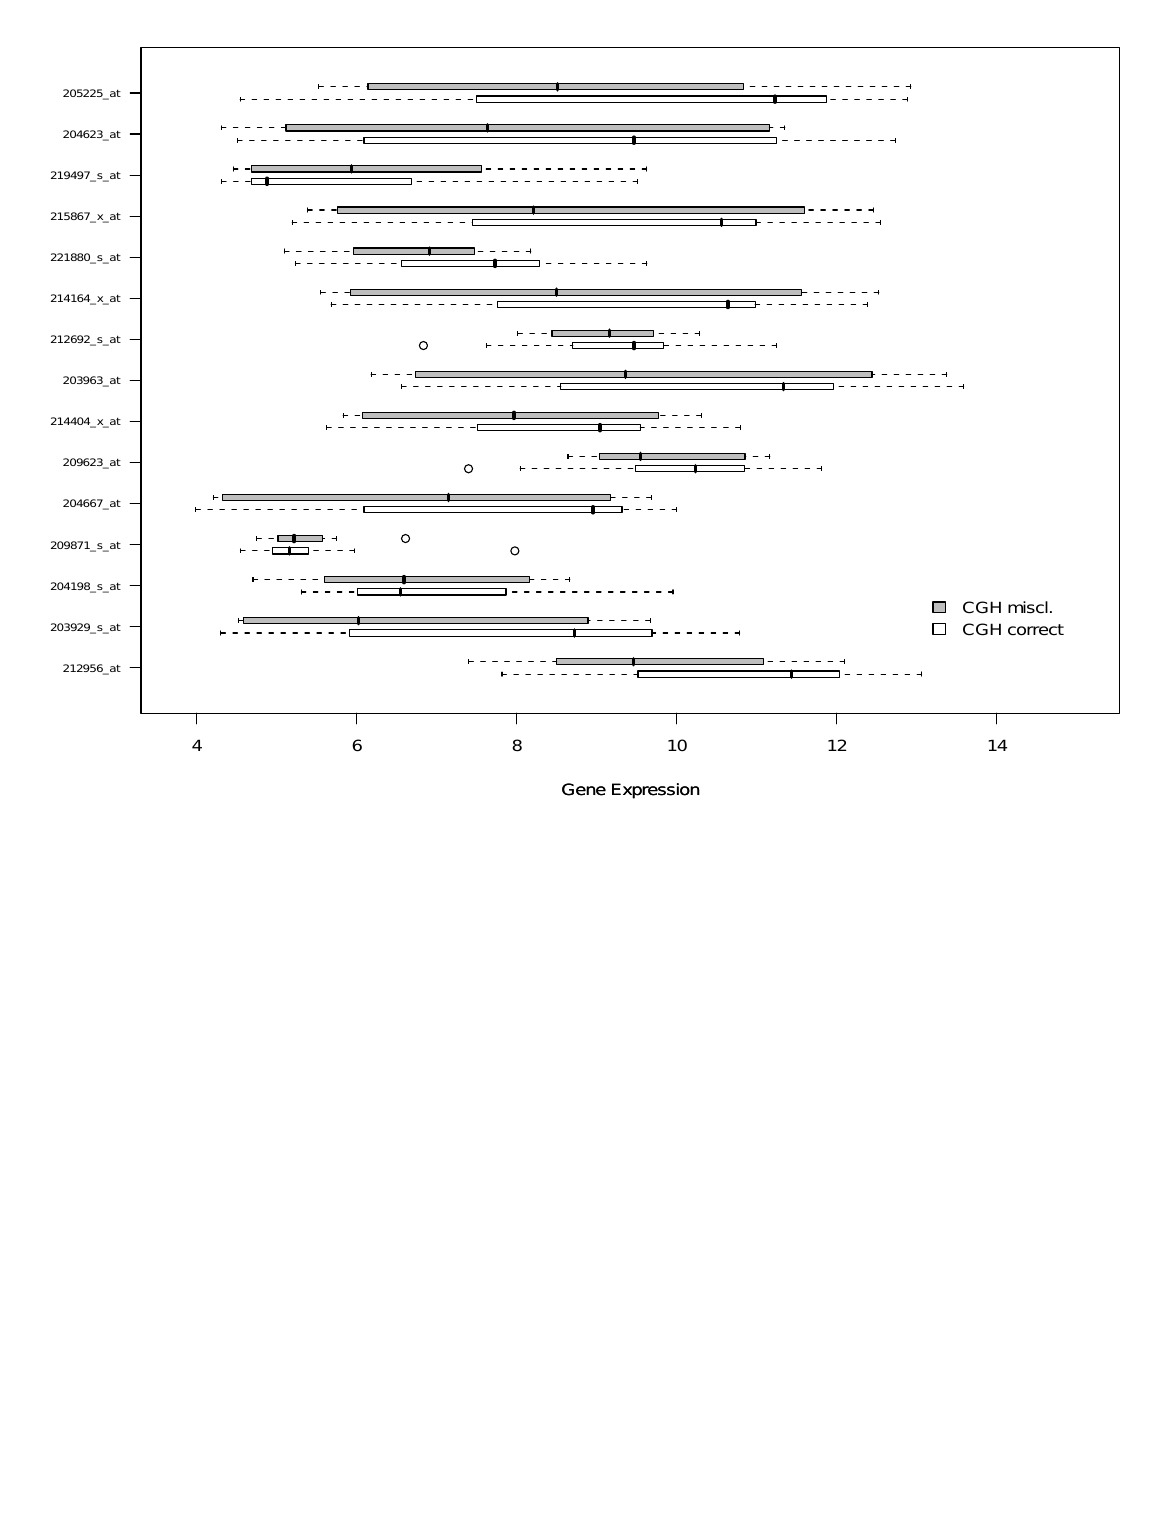
Comparison of gene expression on optimal gene expression signature of the 8 aCGH misclassified samples with the remaining 55